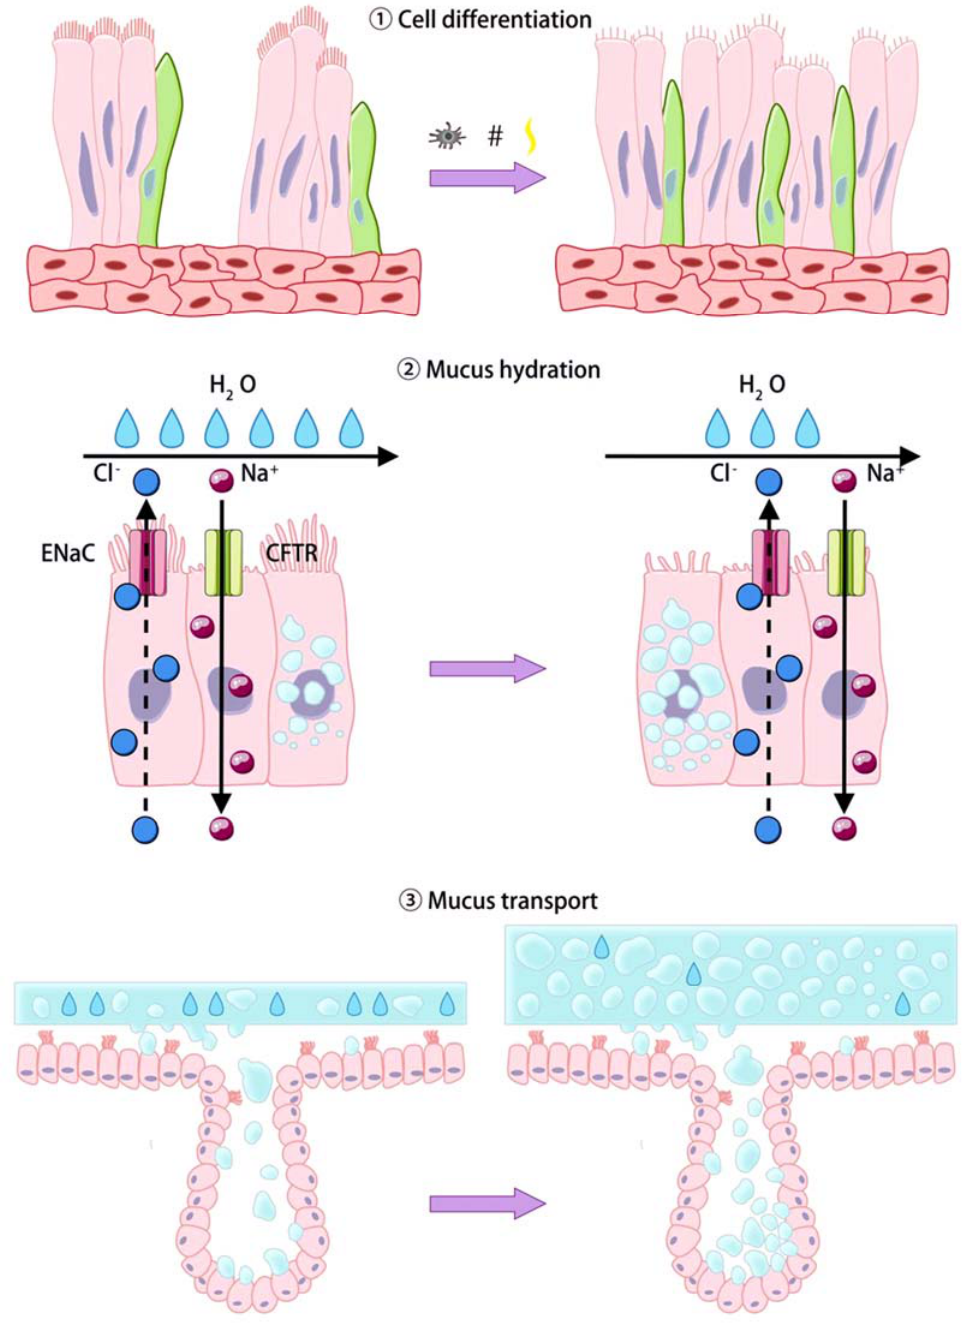
Figure 2. The process of mucin secretion and transport. There are three major steps in this process: (1) Goblet cell differentiation; (2) Dysfunction of chloride and sodium channels leads to mucus hydration; (3) Ciliated cell wobble and expel mucus.